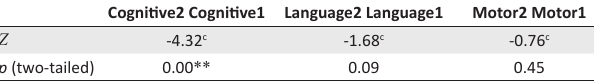
TABLE 4: Test statistics for the comparison of the intervention ( N = 29) and control groups ( N = 34) for each subscale after the intervention. Cognitive Language